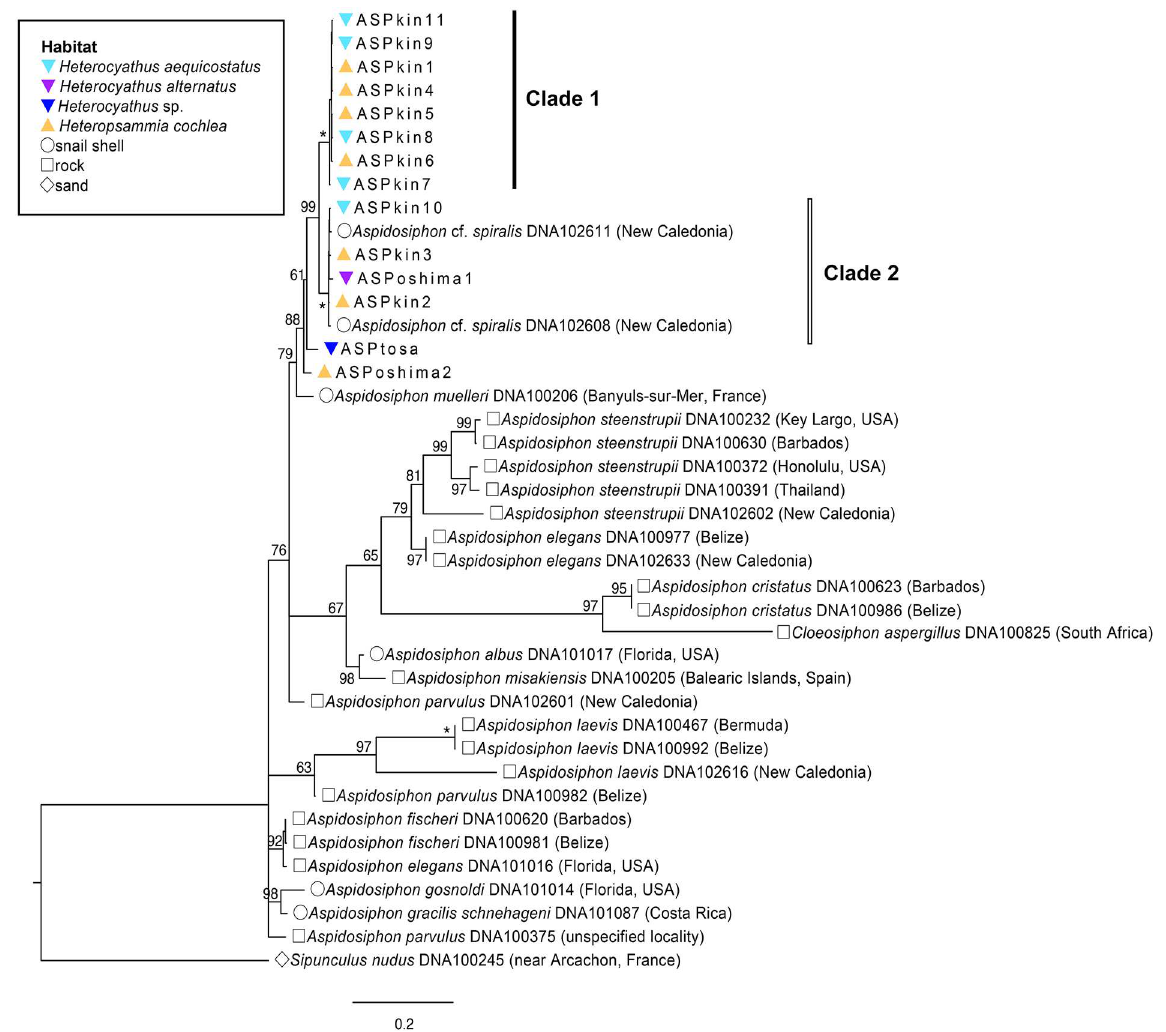
Fig 3. Maximum-likelihood tree of Aspidosiphon sipunculans based on the combined data set of five gene regions. Numbers on nodes indicatemaximum-likelihoodbootstrap support values. Asterisks correspond to BS = 100%. ASPkin1–11, ASPoshima1–2, and ASPtosa are sample numbers given to the specimenscollectedfrom Kin Bay, Oshima Strait, and Tosa Bay, respectively. Each symbol to the left of species names indicatessipunculan domicile.The accession number and the provenanceof each specimenare also